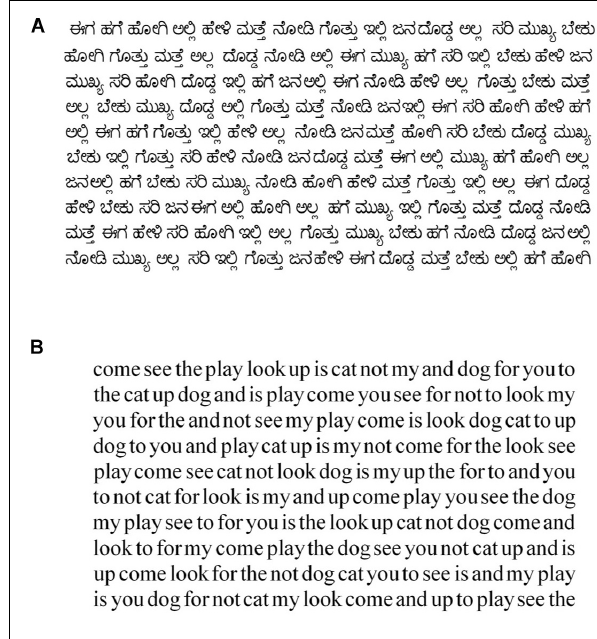
FIGURE 1 | Examples of a Kannada (A) and an English (B) rate of reading